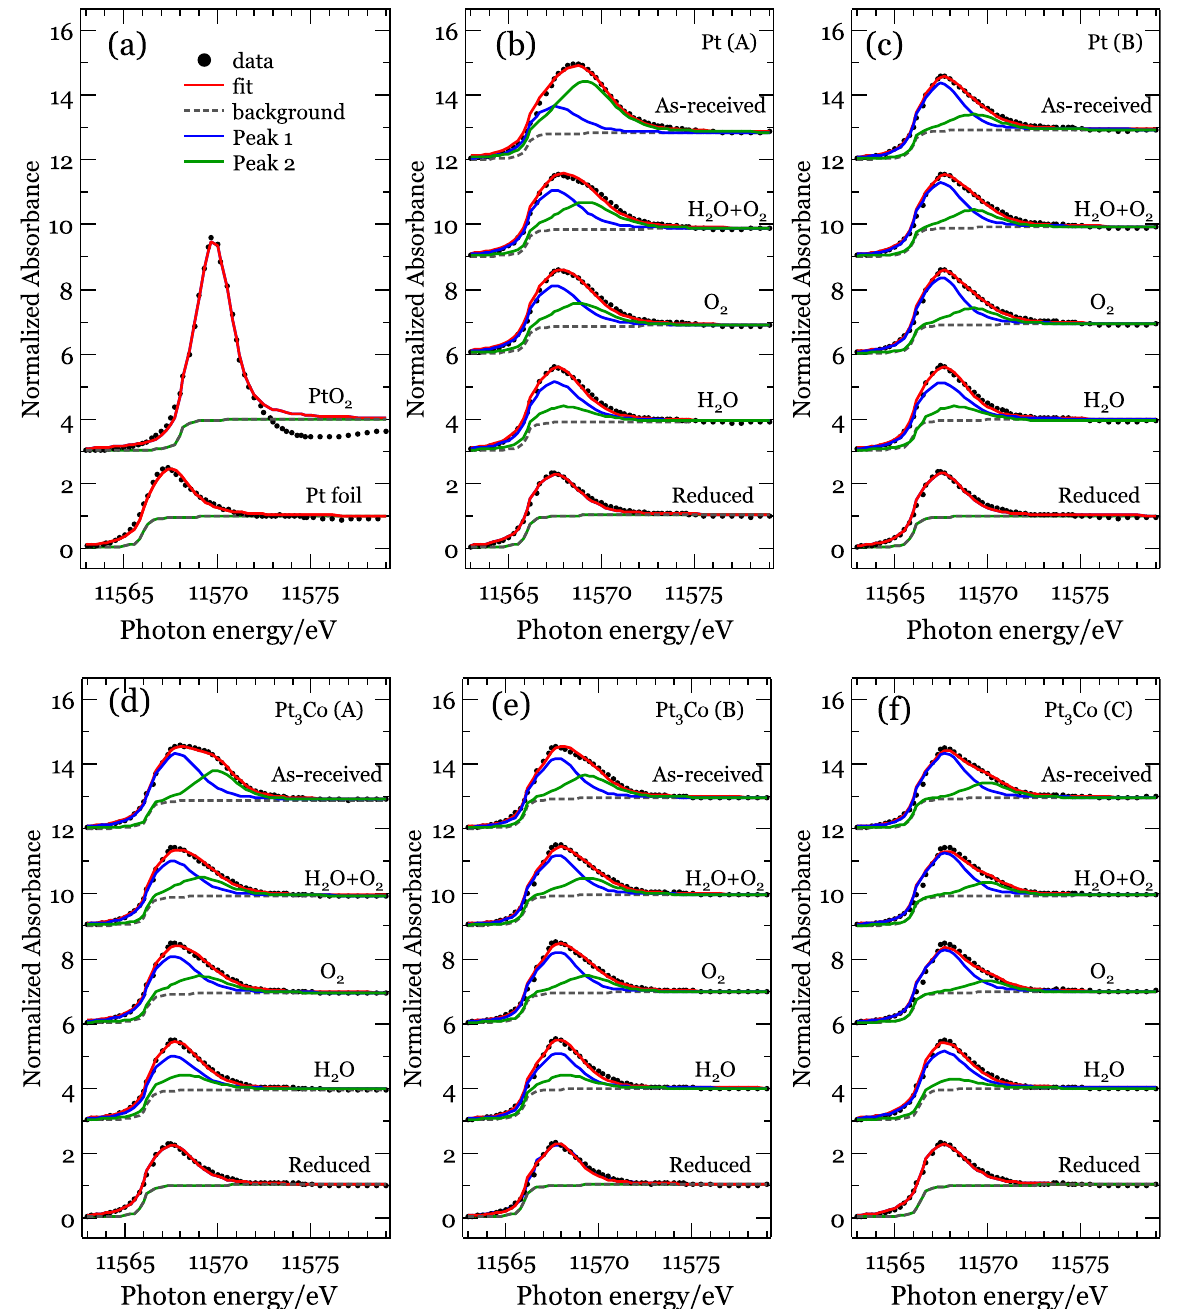
Figure 5. Least-squares fits by two peaks for all HERFD-XAS spectra from Fig. 4. ( a ) Pt foil and PtO 2 powder, ( b ) Pt(A), ( c ) Pt(B), ( d ) Pt 3 Co(A), ( e ) Pt 3 Co(B) and ( f ) Pt 3 Co(C) samples,